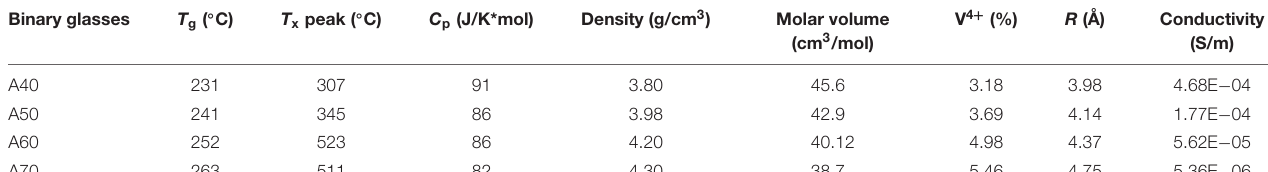
TABLE 1 | Physical property results.